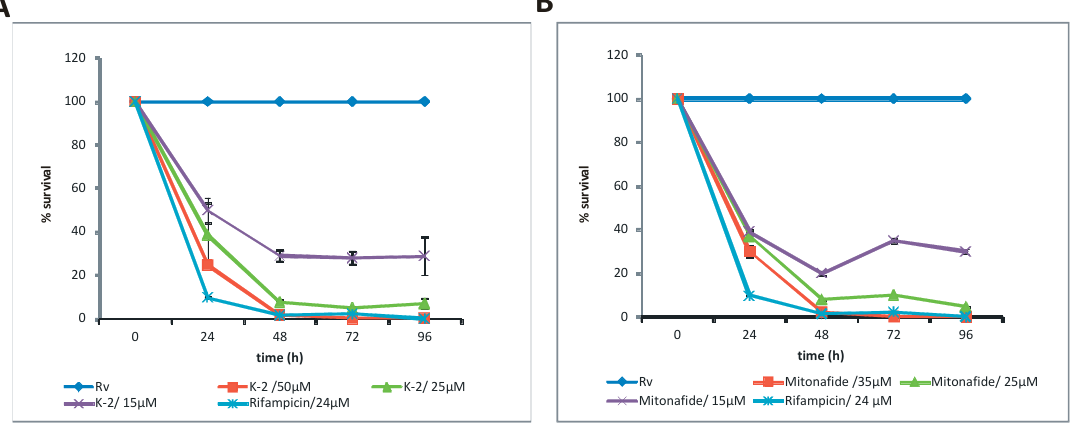
Figure 2. Time-dependent viability of M. tuberculosis at various concentrations of the compound K2-300289 ( A ) and mitonafide ( B ).